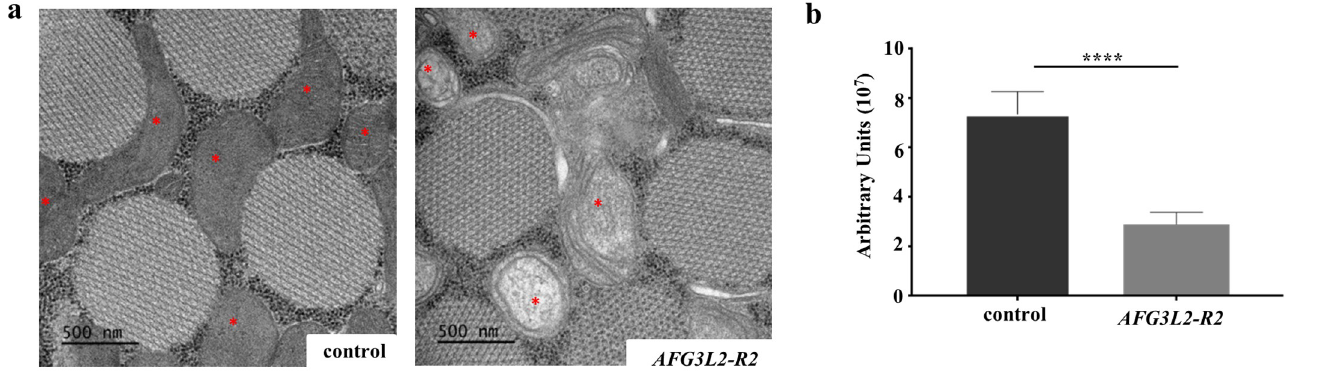
Fig 2. Afg3l2 deficiency results in mitochondrial morphological defects. a. Transmission electron microscopy images of indirect flight muscles from control animals (UAS- LUCIFERASE RNAi/24B-Gal4) and from flies expressing the strong AFG3L2-R2 RNAi (UAS- AFG3L2-R2 RNAi/24B-Gal4) using the mesoderm specific 24B-Gal4 driver. Images are of indirect flight muscles dissected from pupae. The red asterisks denote the mitochondria. b. Quantification of mitochondrial cristae density in control (UAS- LUCIFERASE RNAi/24B-Gal4) and AFG3L2 -deficient (UAS- AFG3L2-R2 RNAi/24B-Gal4) animals ( ���� p < 0.0005 by Student’s t-test).